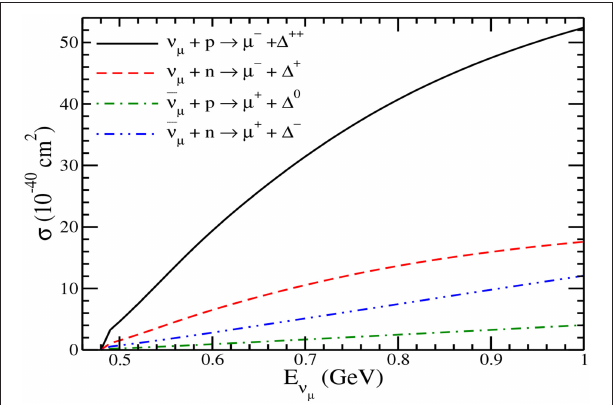
FIGURE 9 | σ vs. E ν µ for the Delta production cross sections. Solid line represents the result for 1 ++ production cross section, dashed line represents the result for 1 + cross section, dash-dotted line represents the result for 1 0 production and the dash-double-dotted line represents the result for the 1 − production cross section.